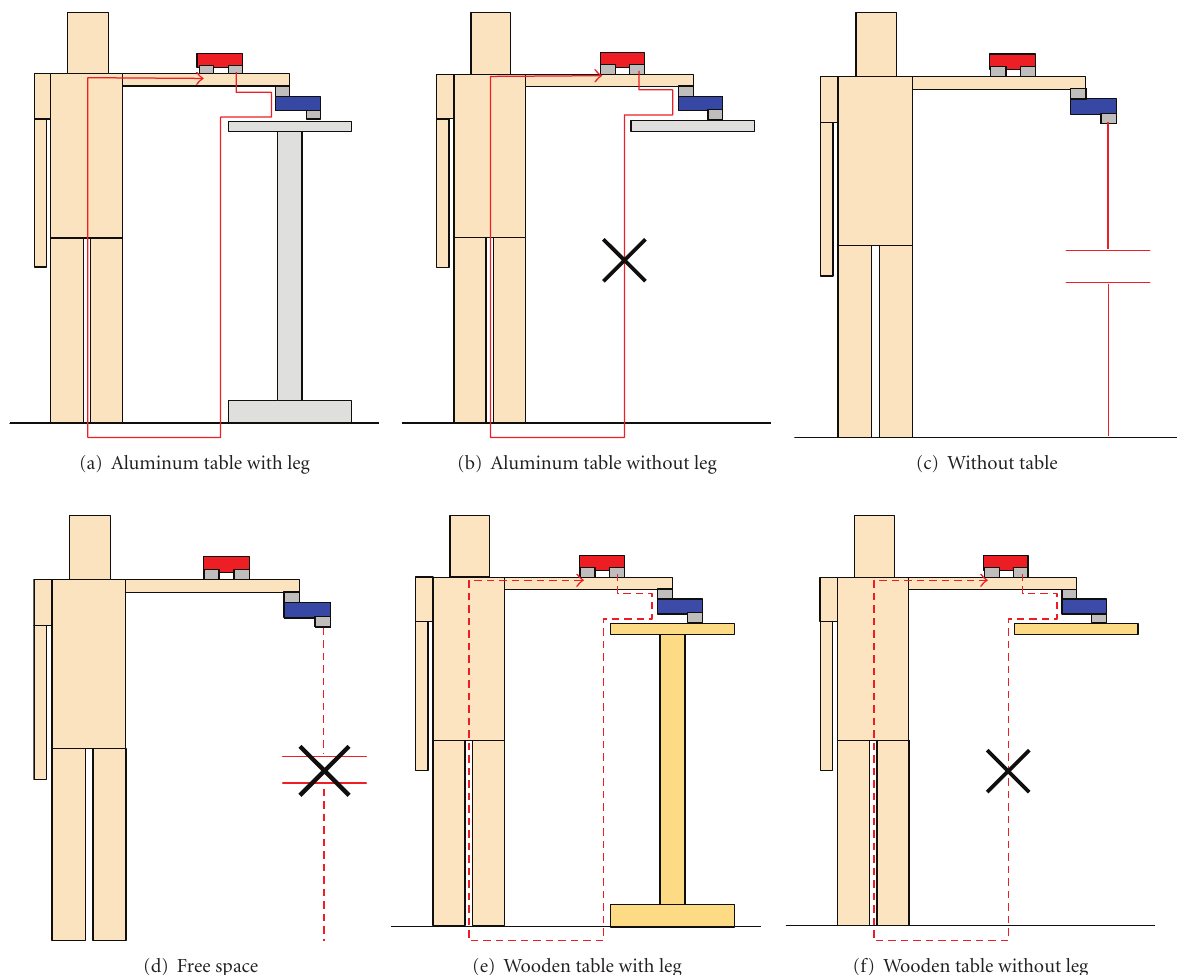
Figure 10: Analysis models for the e ff ect of current loop